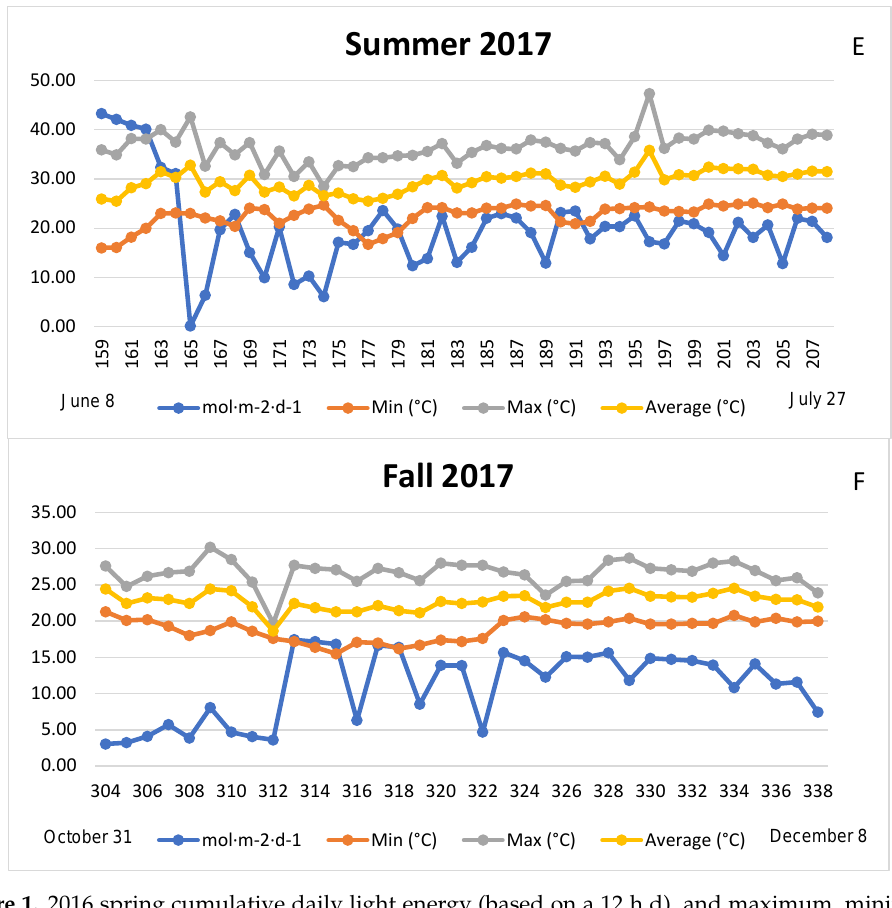
Figure 1. 2016 spring cumulative daily light energy (based on a 12 h d), and maximum, minimum, and average daily temperature ( A ); summer cumulative daily light energy, and maximum, minimum, and average daily temperature ( B ); fall cumulative daily light energy, and maximum, minimum, and average daily temperature ( C ); 2017 spring cumulative daily light energy, and maximum, minimum, and average daily temperature ( D ); summer cumulative daily light energy, and maximum, minimum, and average daily temperature ( E ); and fall cumulative daily light energy, and maximum, minimum, and average daily temperature ( F ).